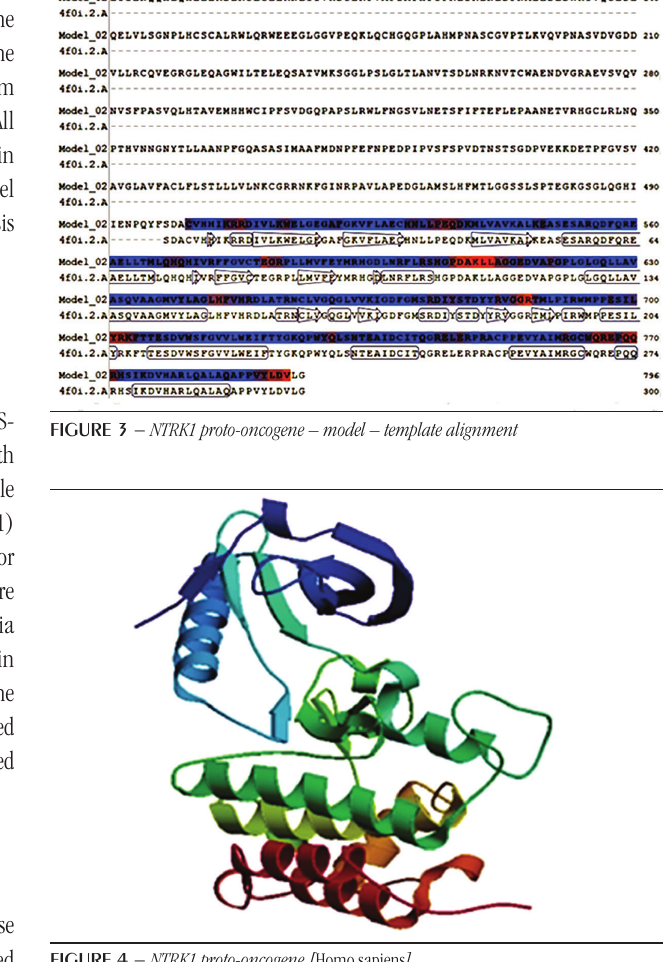
figurE 4 − NTRK1 proto-oncogene [ Homo sapiens